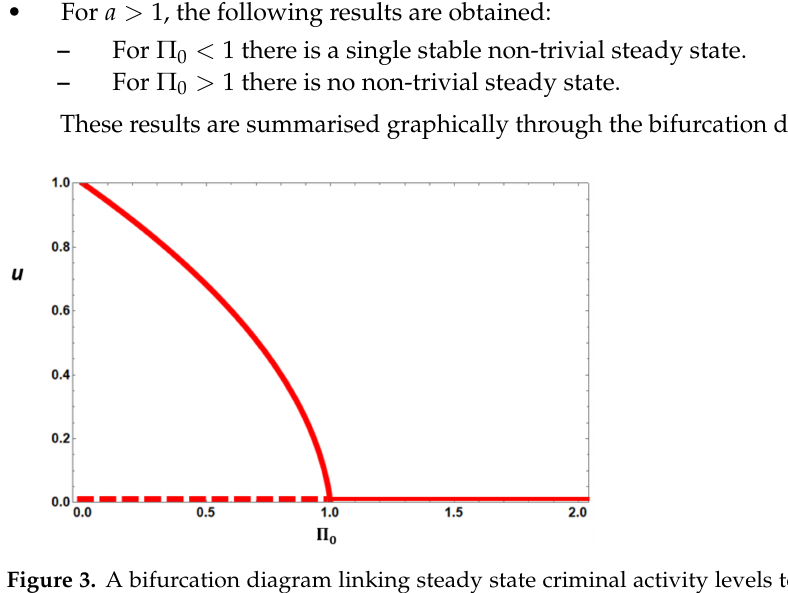
Figure 3. A bifurcation diagram linking steady state criminal activity levels to policing efficiency. The solid line corresponds to a stable steady state and the dashed line to an unstable steady state. In this case, with a = 1.2, we are considering high policing responsiveness to criminal activity. A transcritical bifurcation is observed.